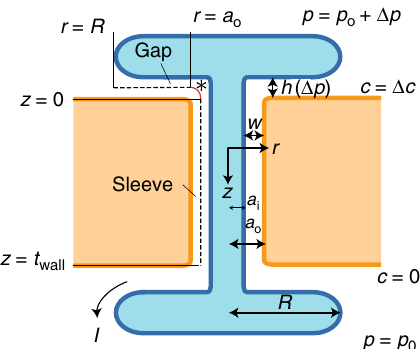
Fig. 6 Schematic of the PD pore geometry. Transport of molecules by molecular diffusion is driven by a difference in solute concentration Δ c across the cell wall. The diffusive current I is determined from solutions in the gap and sleeve domains (see Eqs. (9) and (10)). The short gap-sleeve transition region of length w ~ h (indicated by an asterisk) is not included in the analysis. See also Figs. 1 and 2